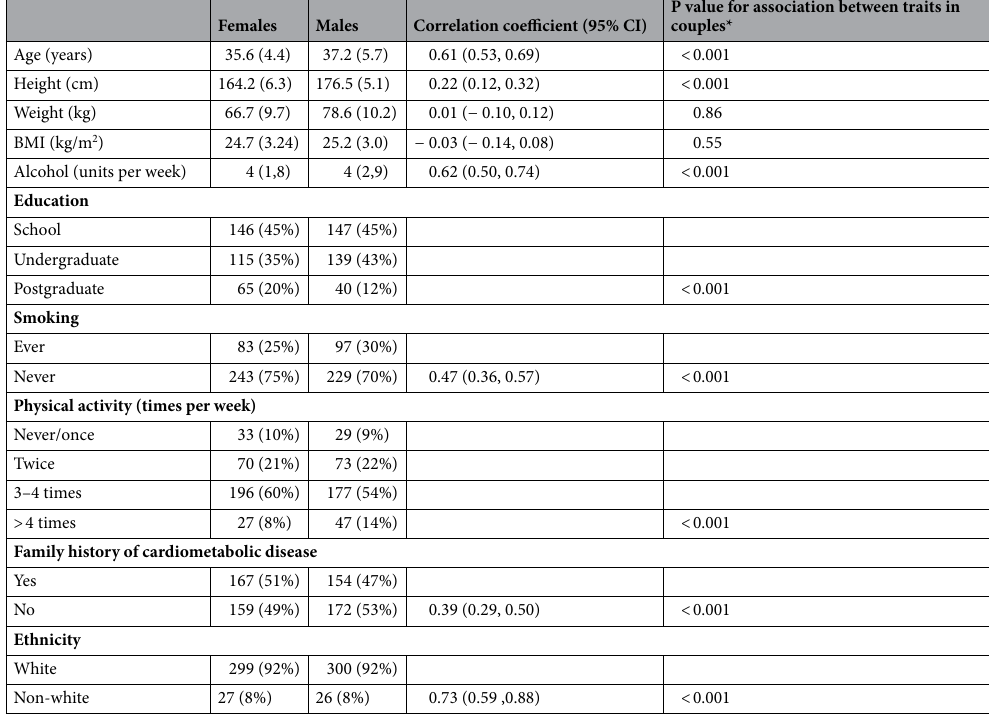
Table 1. Demographic/lifestyle characteristics of couples undergoing IVF treatment (N = 326). *From Pearson’s correlation/chi square